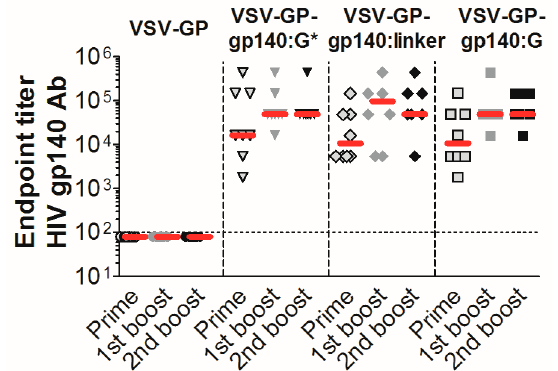
Figure 5. VSV-GP-Env particles induce high titers of gp140 binding antibodies in mice. Groups of 8 C57BL/6 mice were immunized intramuscularly with 10 7 TCID 50 of VSV-GP, VSV-GP-gp140:G*, VSV- GP-gp140:G or VSV-GP-gp140:G-linker at week 0, 4, and 8. Four weeks after each immunization, plasma was collected and analyzed for the titer of gp140-binding antibodies using an ELISA (enzyme- linked immunosorbent assay). The median for each group (red line) and the titer for each individual animal are shown. The dotted line shows the detection limit of the